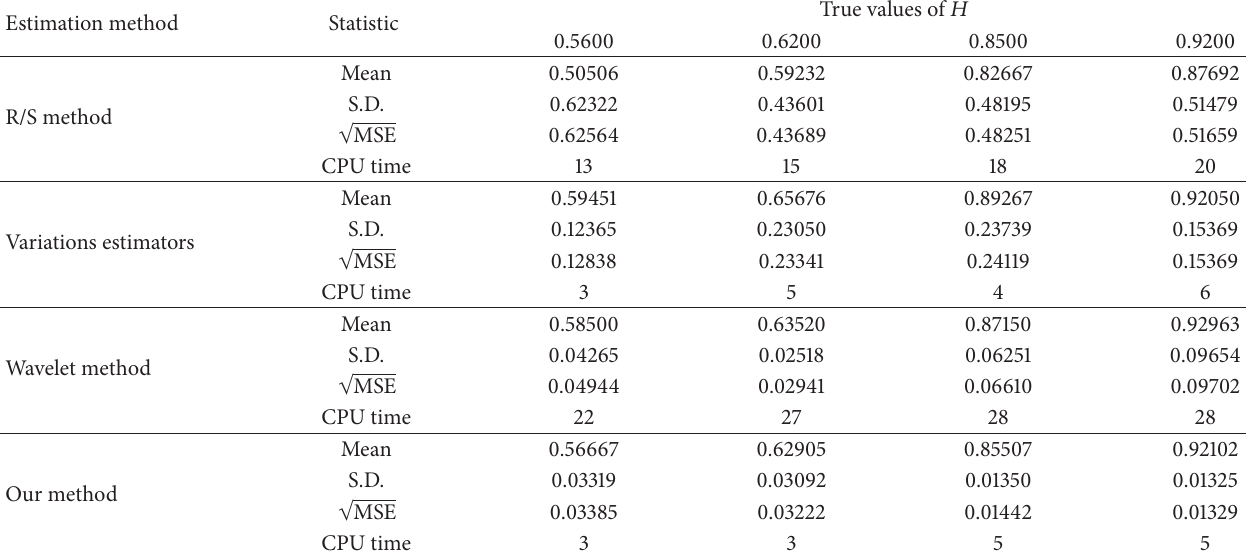
Table 1: The estimation results of comparative methods for sample size 𝑁 = 50 .